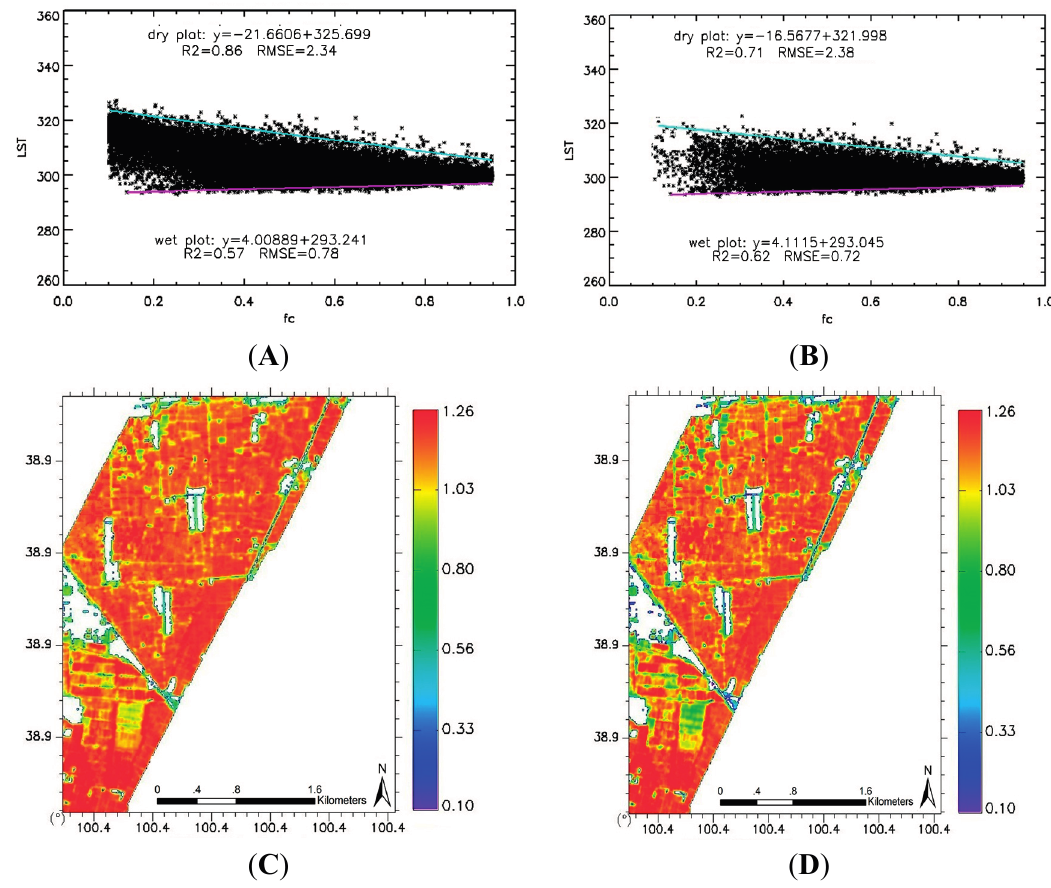
Figure 6. The LST-Fc feature space constructed respectively by: ( A ) using the WiDAS image, denoted as original feature space; ( B ) using WiDAS image data without erroneous dry pixels, denoted as refined feature space. ( C , D ) the results of coefficient φ estimated from LST-Fc feature space (A) and (B)